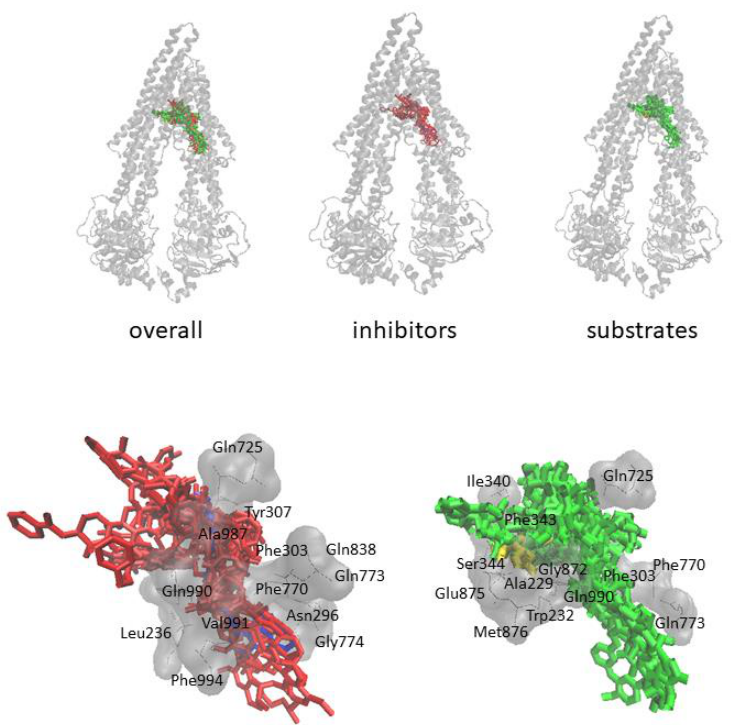
Figure 4. Molecular docking results for selected inhibitors (red) and substrates (green) yielded from the P-gp inhibitor / substrate prediction model. Elacridar (blue) and doxorubicin (yellow) were selected as control drugs.